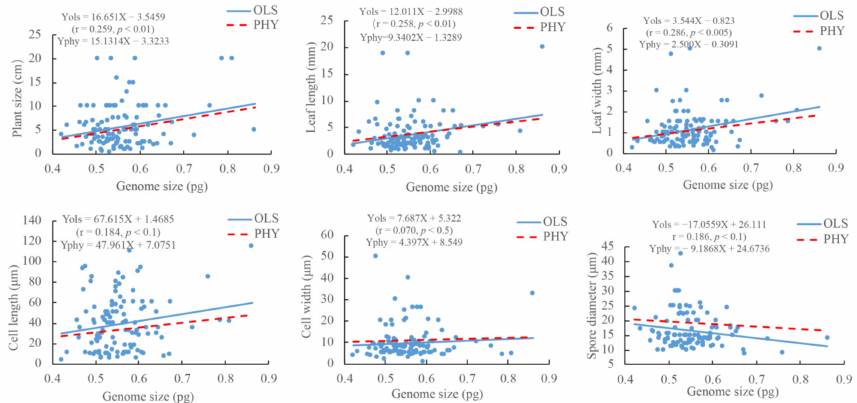
Figure 3. Relationships of DNA 1C value (genome size) with the sizes of plants, leaves, cells and spores for the 112 moss species. Note: the OLS line represents the relationship modeled by using the ordinary least squares, while the PHY line represents the relationship by using phylogenetically controlled